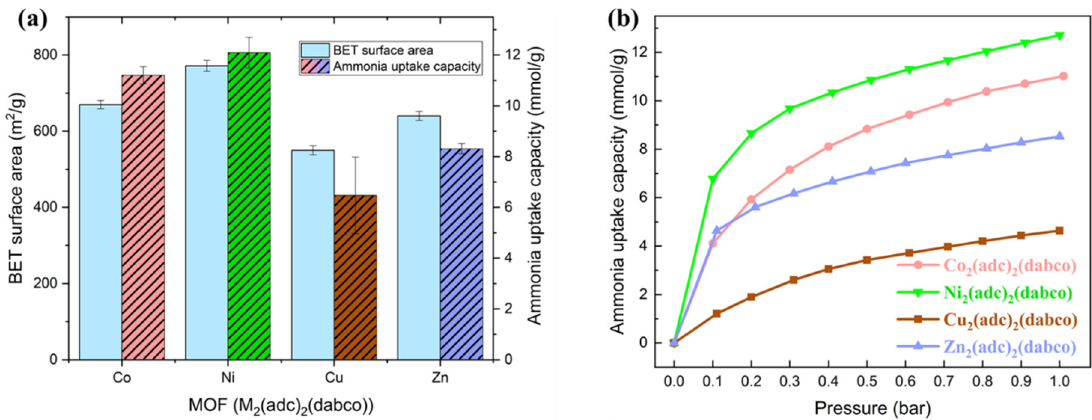
Figure 3. ( a ) The bar chart of the BET surface area and the average ammonia uptake capacity for three cycles of the MOFs [M 2 (adc) 2 (dabco)] (M = Co, Ni, Cu, Zn). ( b ) The isotherms of ammonia adsorption in the MOFs [M 2 (adc) 2 (dabco)] (M = Co, Ni, Cu, Zn) at 22 °C from high vacuum to 1 bar.